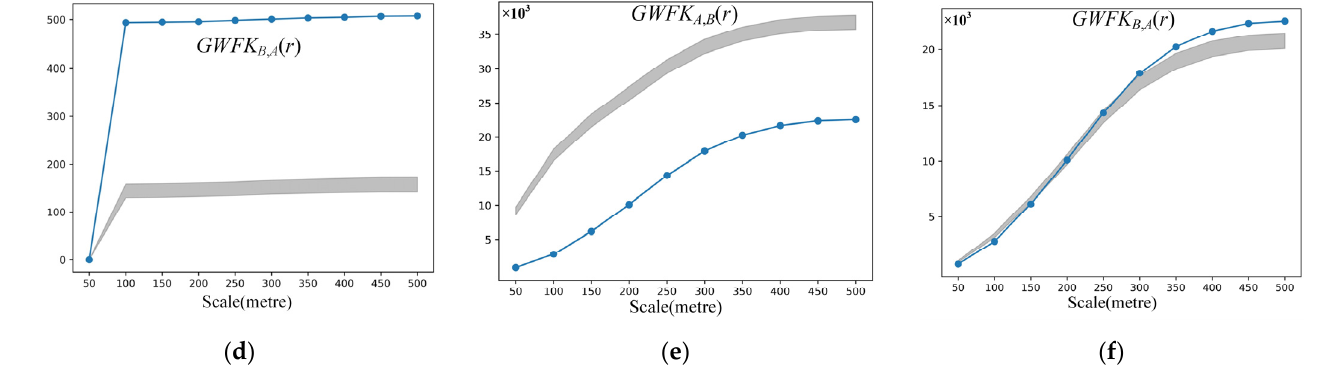
Figure 2. Results of the simulated datasets: ( a , b ) simulated dataset 1; ( c , d ) simulated dataset 2; ( e , f ) simulated dataset 3.